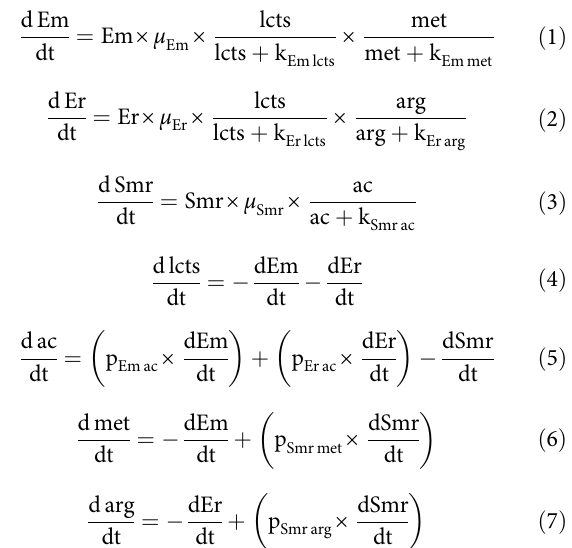
rates are µ Em = 1.0, µ Er = 1.1, and µ Smr = 0.5 with units of 1/timestep.